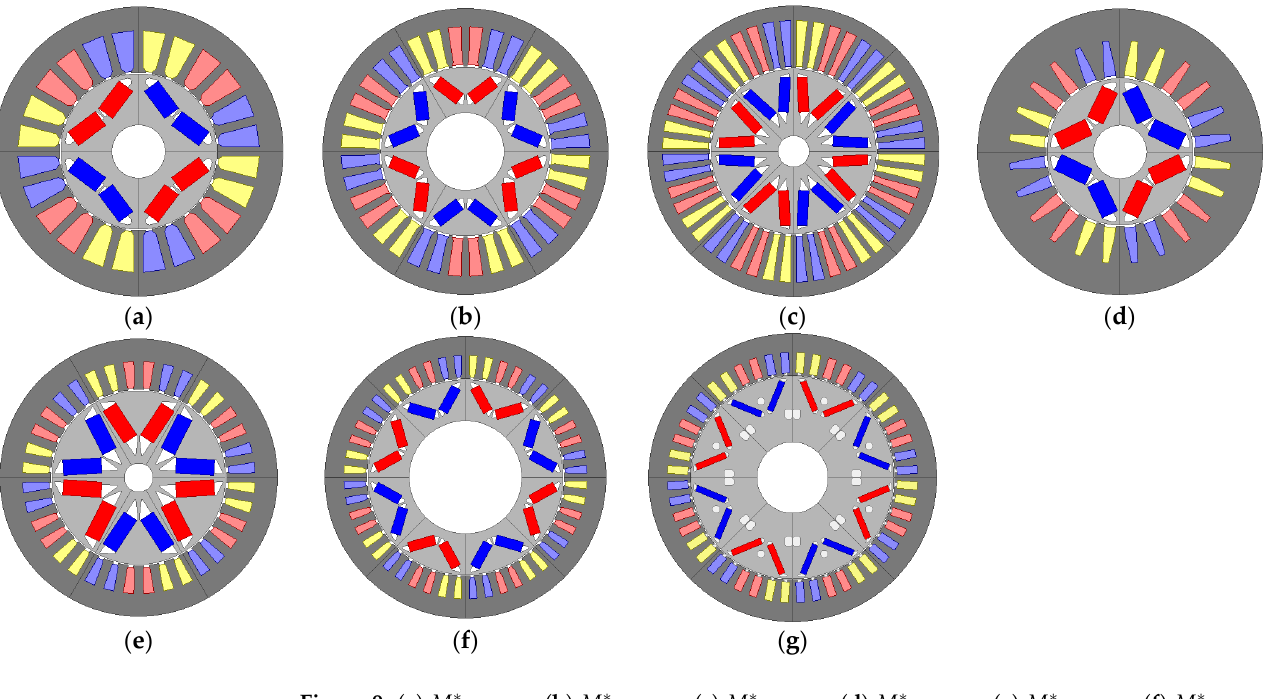
Figure 9. ( a ) 𝑀 (cid:2869)(cid:2873)(cid:2879)(cid:2870)(cid:2879)(cid:3004)(cid:3021)∗ , ( b ) 𝑀 (cid:2869)(cid:2873)(cid:2879)(cid:2871)(cid:2879)(cid:3004)(cid:3021)∗ , ( c ) 𝑀 (cid:2869)(cid:2873)(cid:2879)(cid:2872)(cid:2879)(cid:3004)(cid:3021)∗ , ( d ) 𝑀 (cid:2869)(cid:2873)(cid:2879)(cid:2870)(cid:2879)(cid:3015)(cid:3021)∗ , ( e ) 𝑀 (cid:2869)(cid:2873)(cid:2879)(cid:2871)(cid:2879)(cid:3015)(cid:3021)∗ , ( f ) 𝑀 (cid:2869)(cid:2873)(cid:2879)(cid:2872)(cid:2879)(cid:3015)(cid:3021)∗ , ( g ) Figure 9. ( a ) M ∗ , ( b ) M ∗ , ( c ) M ∗ , ( d ) M ∗ , ( e ) M ∗ , ( f ) M ∗ , 15 − 2 − NT 15 − 3 − NT 15 − 4 − NT 15 − 2 − CT 15 − 3 − CT 15 − 4 − CT Machine used in Peugeot e208. ( g ) Machine used in Peugeot